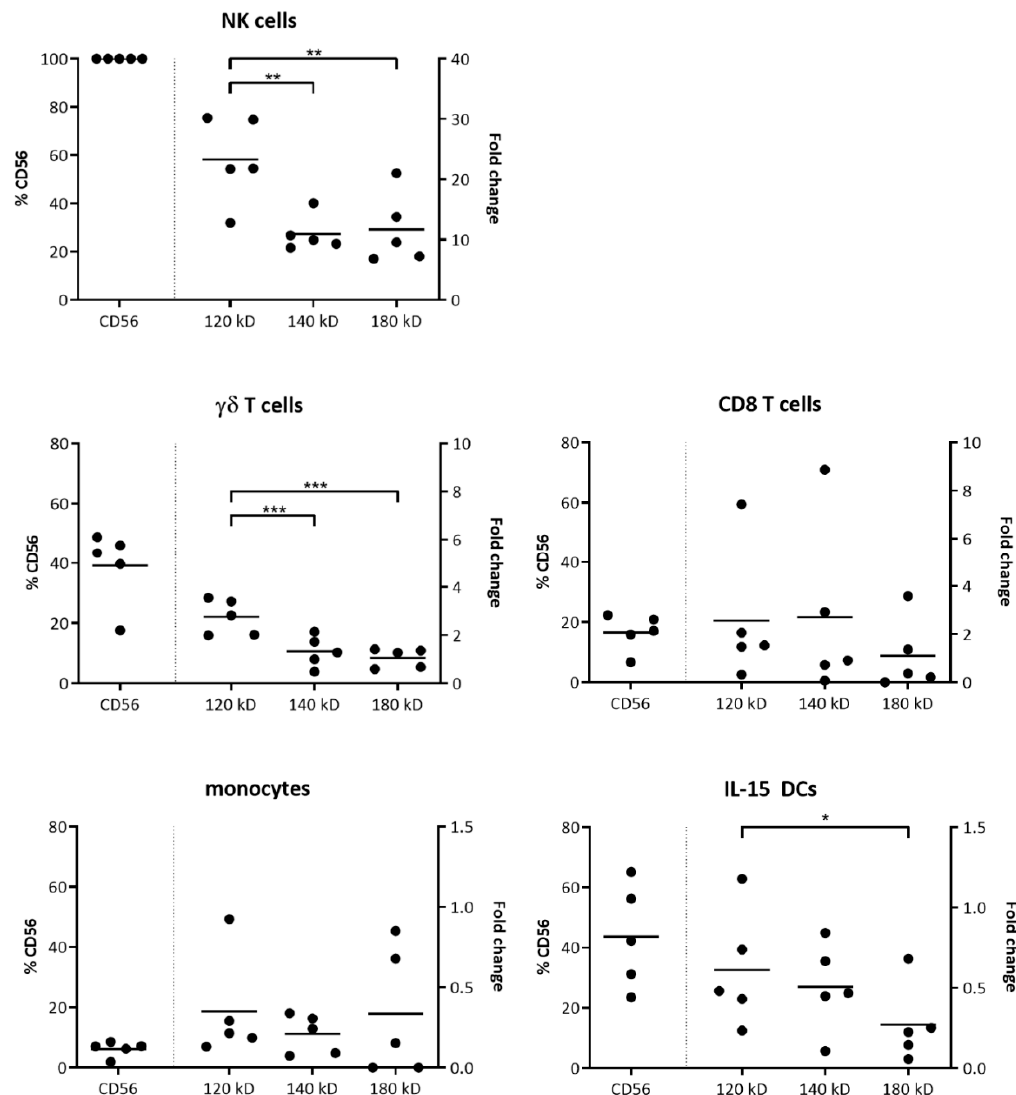
Figure 1. Cluster of differentiation (CD)56 (isotype) expression by different immune cell subsets. Juxtaposition of the percentage CD56 expression on different immune cell subsets as determined by flow cytometry (left y -axis) and CD56 isoform (120–140–180 kD) mRNA expression (scaled to average) determined by qPCR (right y -axis). Data from five donors are represented as scatter plots. One-way ANOVA with Bonferroni’s multiple comparison test or Friedman test with Dunn’s multiple comparison test was used. *** p < 0.001; ** p < 0.01; * p < 0.5.